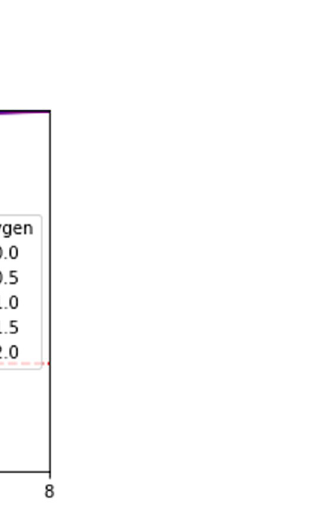
Fig 10. Hepatocyte damage with varied rates of reperfusion treated at the 8th